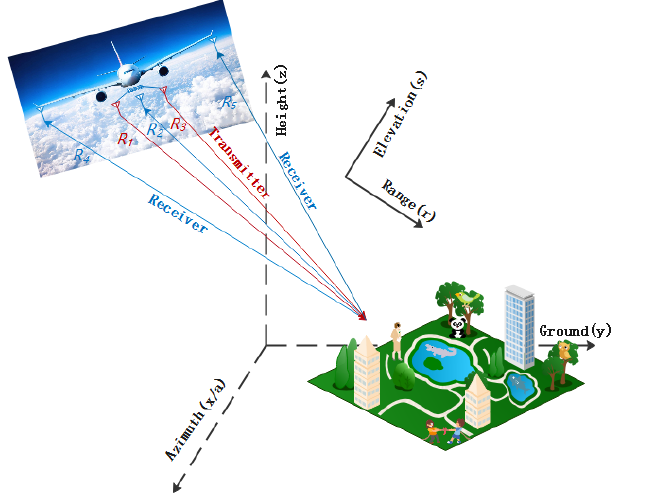
Figure 1. The schematic diagram of flexible mounting of airborne array flexible